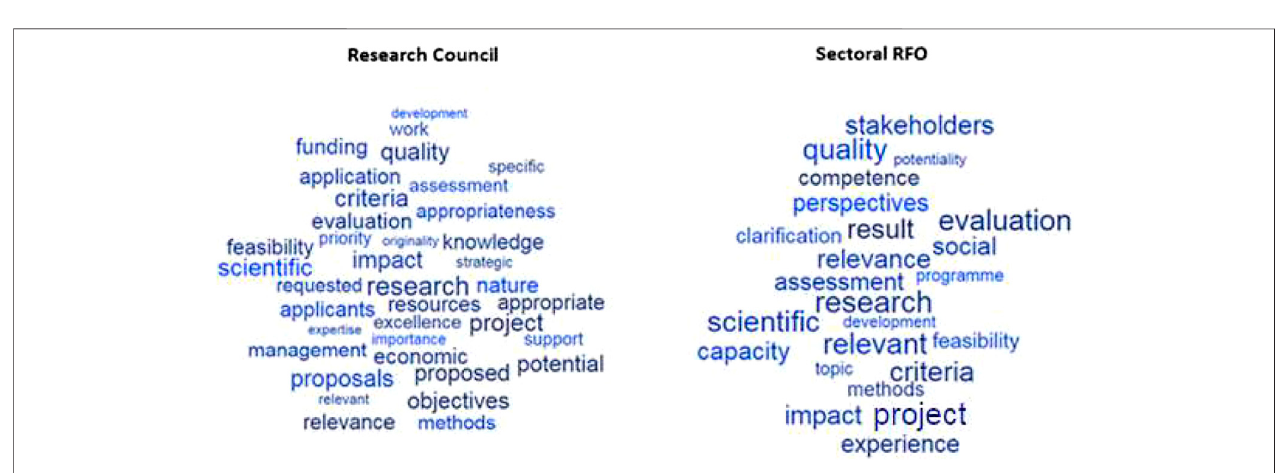
FIGURE 5 | Word Clouds of funding instruments with no orientation and with a policy orientation by Research Council and Sectoral RFO.